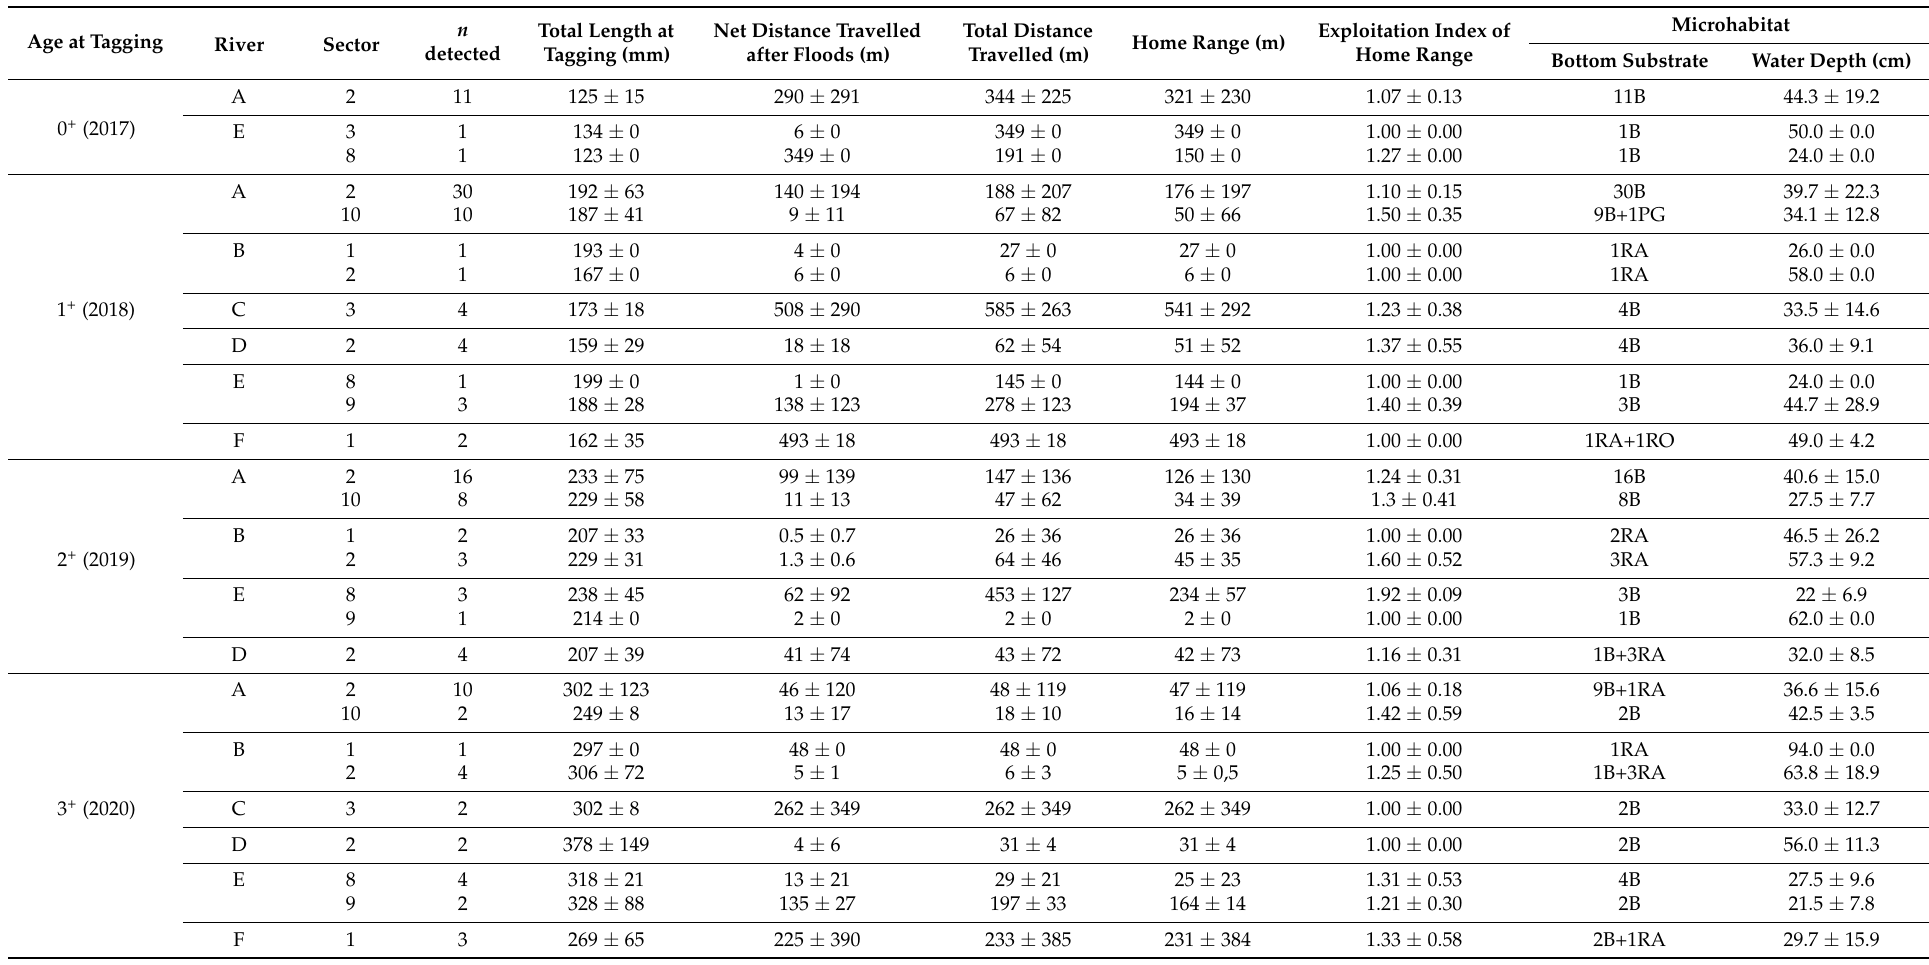
Table 2. Mobility of eels 5 + (based on the spring 2022 telemetry session) according to both age and total length at the time of tagging and characteristics of their microhabitats. The values are the mean and standard error. RO means boulders, B indicates block, PG refers to large stones and RA is submerged roots. The rivers are A , B , C , D , E and F . Floods occurred in July 2021 and eels 4 + were tagged in autumn 2021 after flooding